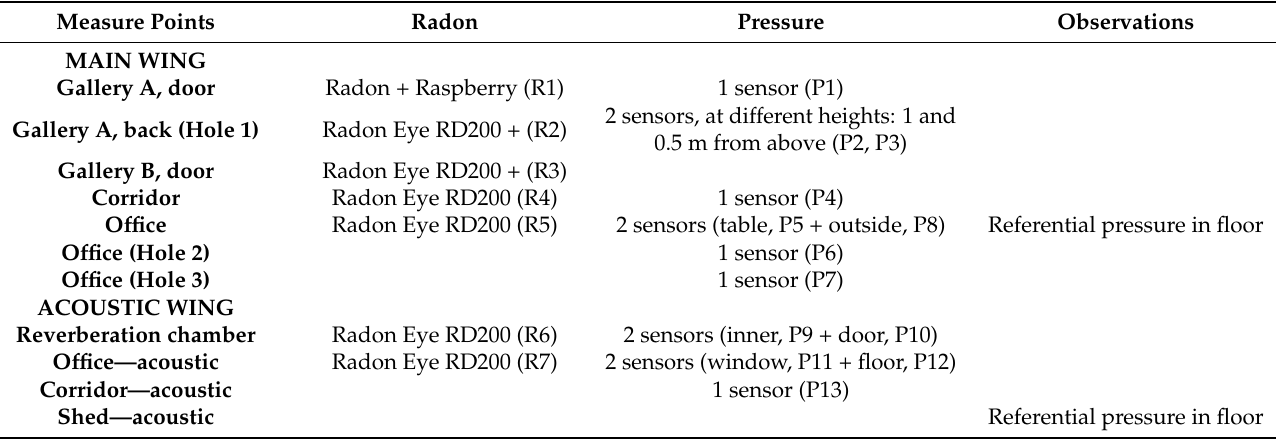
Figure 7. PressureNet system developed by the authors [30]. ( a ) The multiplexer card and ( b ) the modules for pressure sensors. Table 2. Types of sensors and their